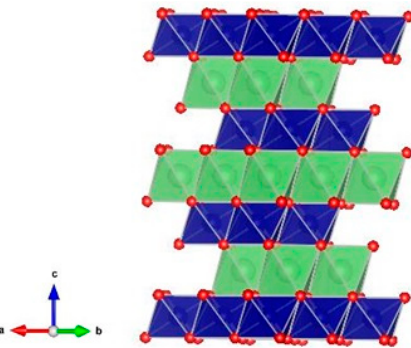
Figure 1. (Colour online) Ambient-pressure crystal structure of the layered structured LiCrO 2 (space group R -3 m ). Lithium (green) and Chromium (blue) atoms are octahedrally coordinated with oxygen atom (red).